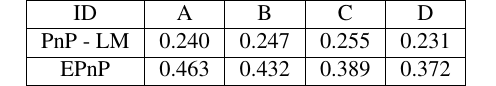
Table 2: Kinects reprojection error for initial pose estimation (in